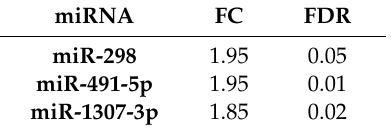
Table 2. The list of serum miRNAs with significantly di ff erent expressions at the baseline between groups (FC > 1.5; FDR ≤ 0.05). miRNA FC FDR